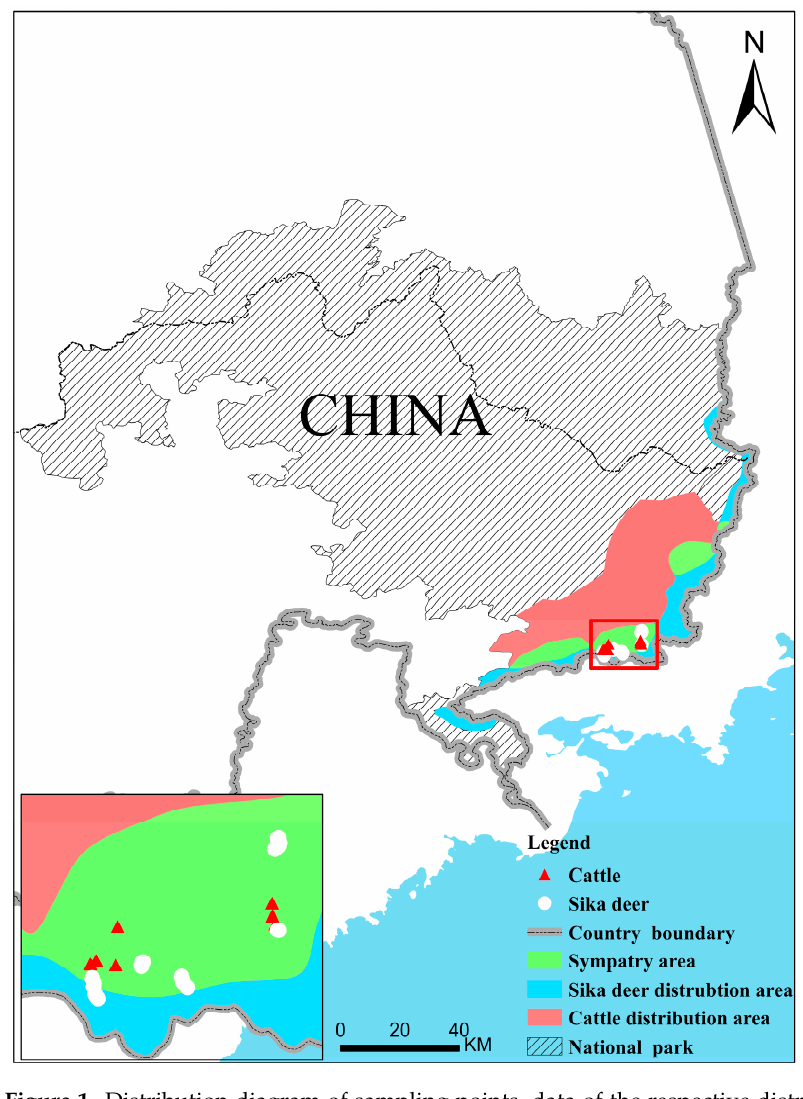
Figure 1. Distribution diagram of sampling points, data of the respective distribution areas, and sympatric distribution areas of cattle and sika deer are from Wang et al. [9].